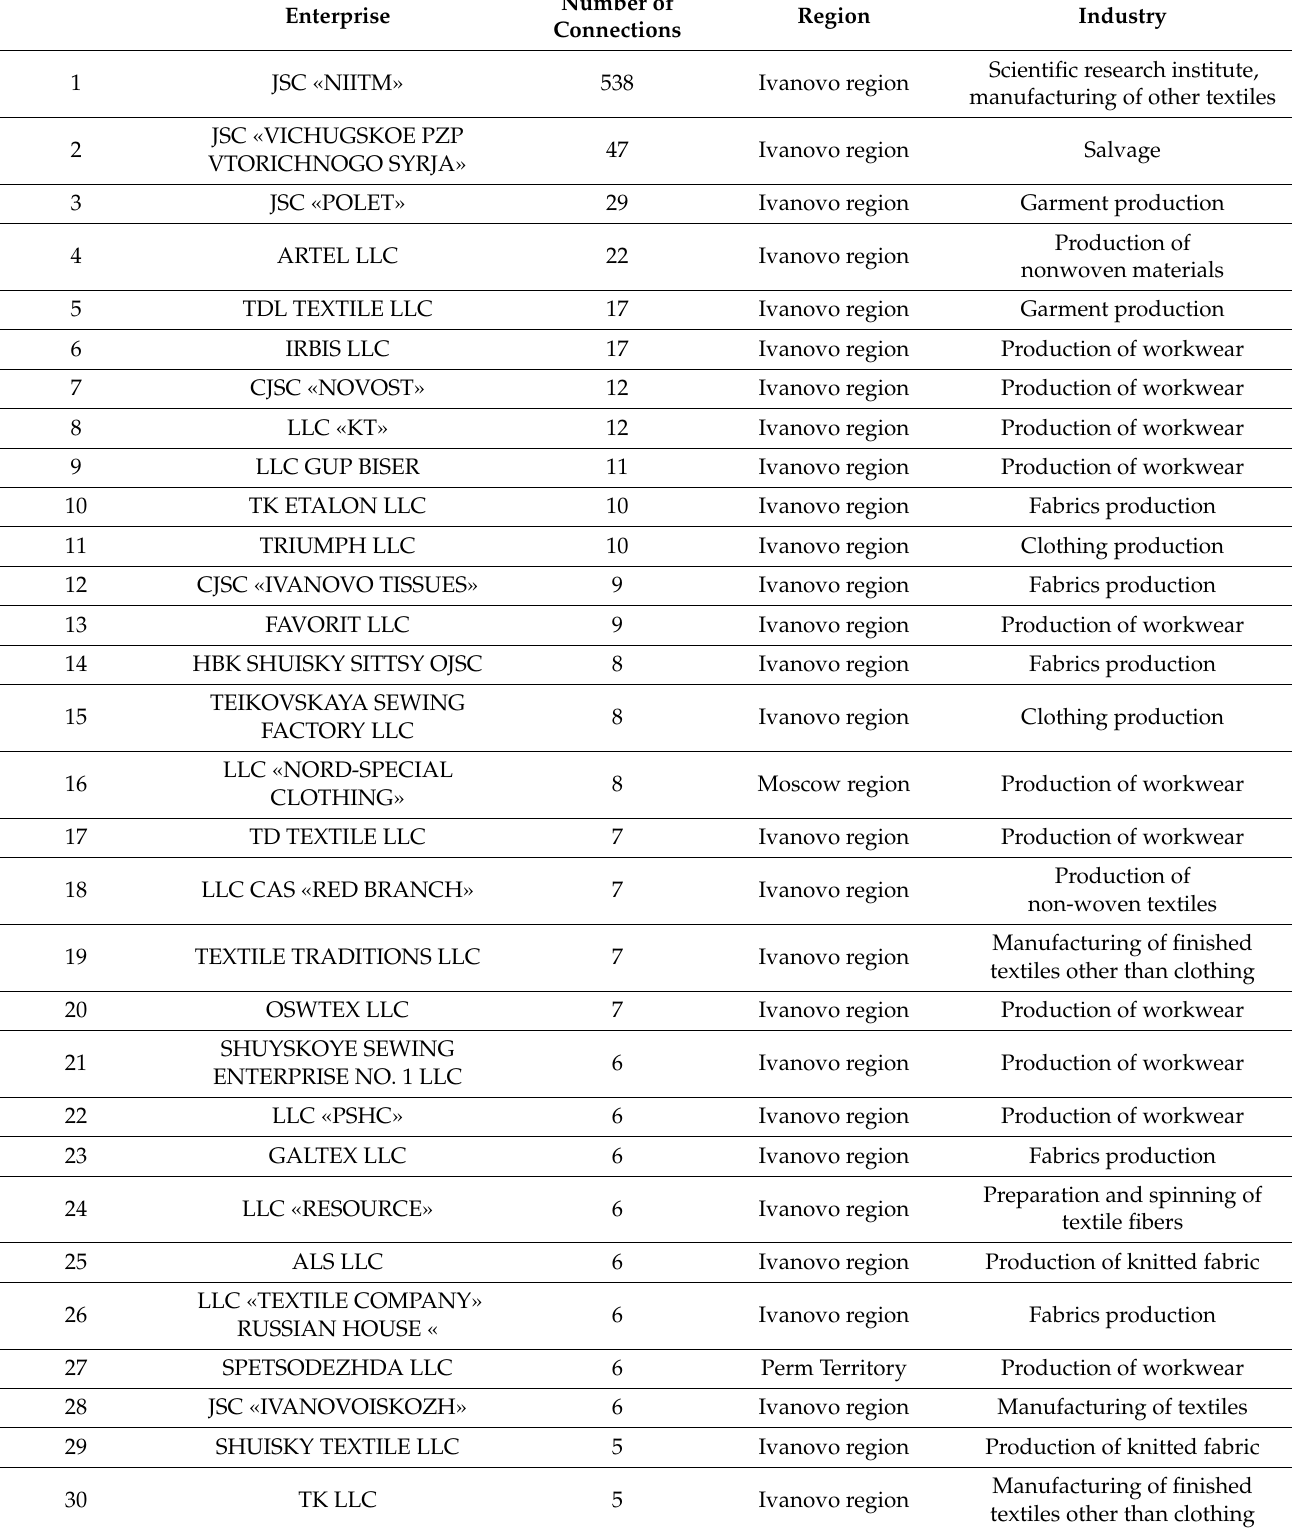
Table A3. Top 30 participants of the Ivanovo textile cluster by the number of